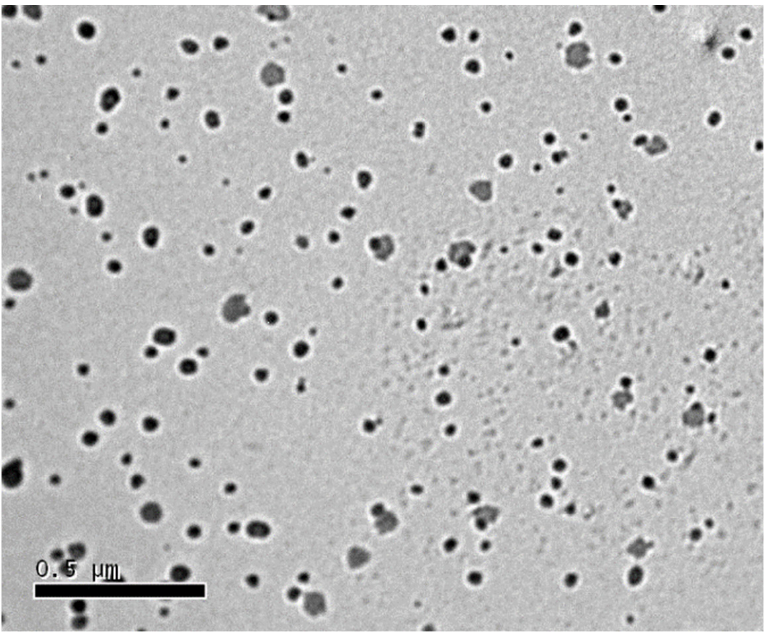
Figure 4. Transmission electron microscopy (TEM) photograph of the tested drug-loaded SEDDS.